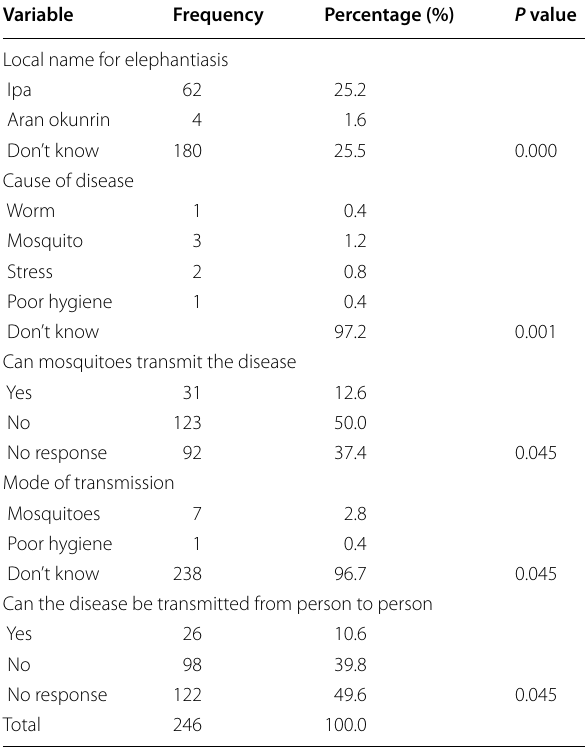
Table 6 Respondents’ knowledge on transmission of